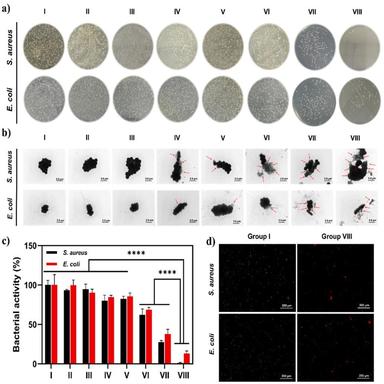
Antibacterial performance in vitro. a) Photographs of remaining E. coli and S. aureus colonies on agar plates in eight groups (n = 3); b) Corresponding TEM images of treated E. coli and S. aureus; c) Corresponding bacterial viability after treatment in different groups (n = 3); (d)SYTO9/PI staining images of E. coli and S. aureus with treatments in group I or VIII. Group I: blank; group II: Fc-PP-POP; group III: laser; group IV: H2O2; group V: H2O2 + laser; group VI: Fc-PP-POP + H2O2; group VII: Fc-PP-POP